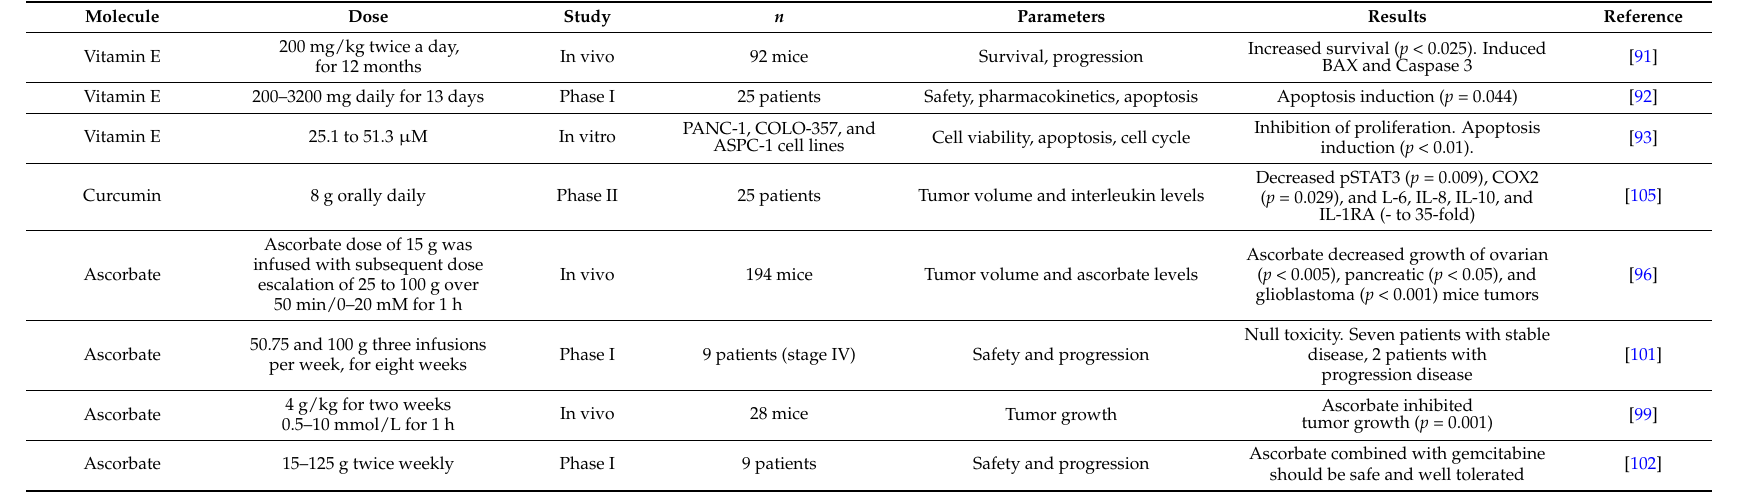
Table 2. Anti-oxidant therapies in